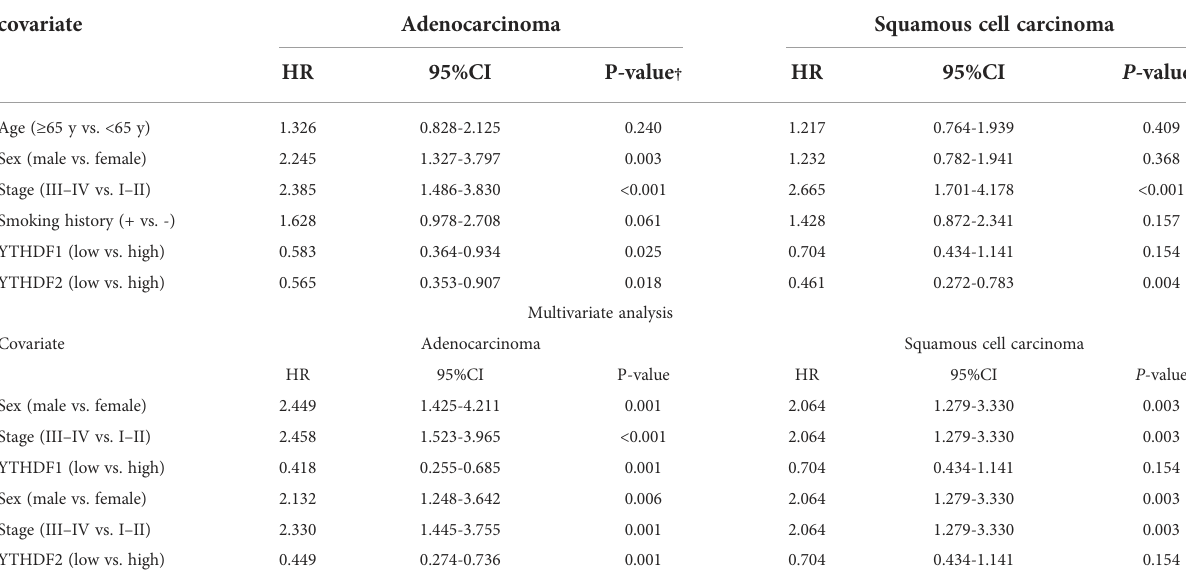
TABLE 2 Univariate and multivariate analyses of overall survival in immunohistochemical data of non-treatment group of PD1/PDL1 Inhibitors. Univariate analysis